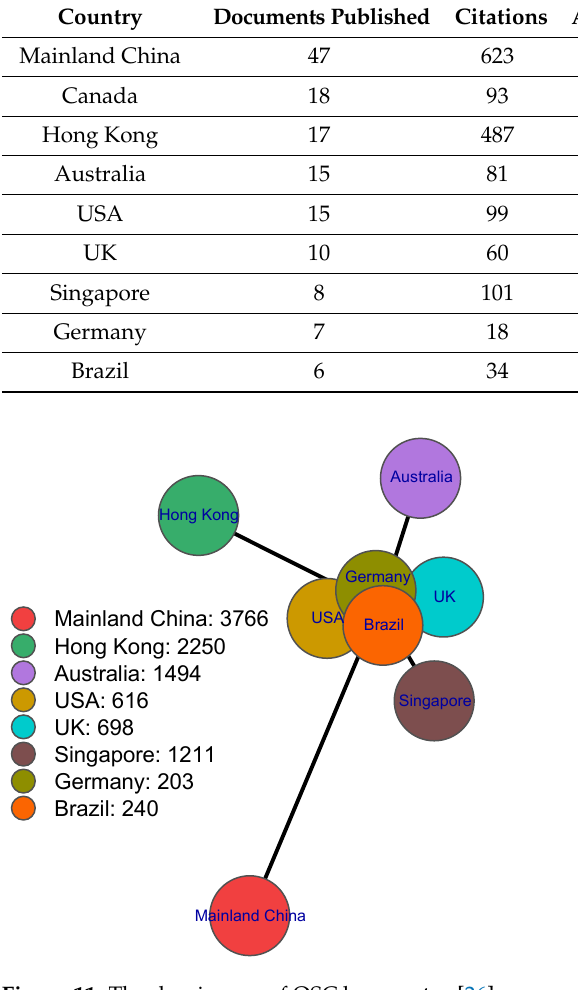
Figure 11. The dominance of OSC by country [26]. Table 9. Adoption of OSC initiatives based on the number of documents and citations in the top nine countries. The numbers indicate the number of citations per country [26].